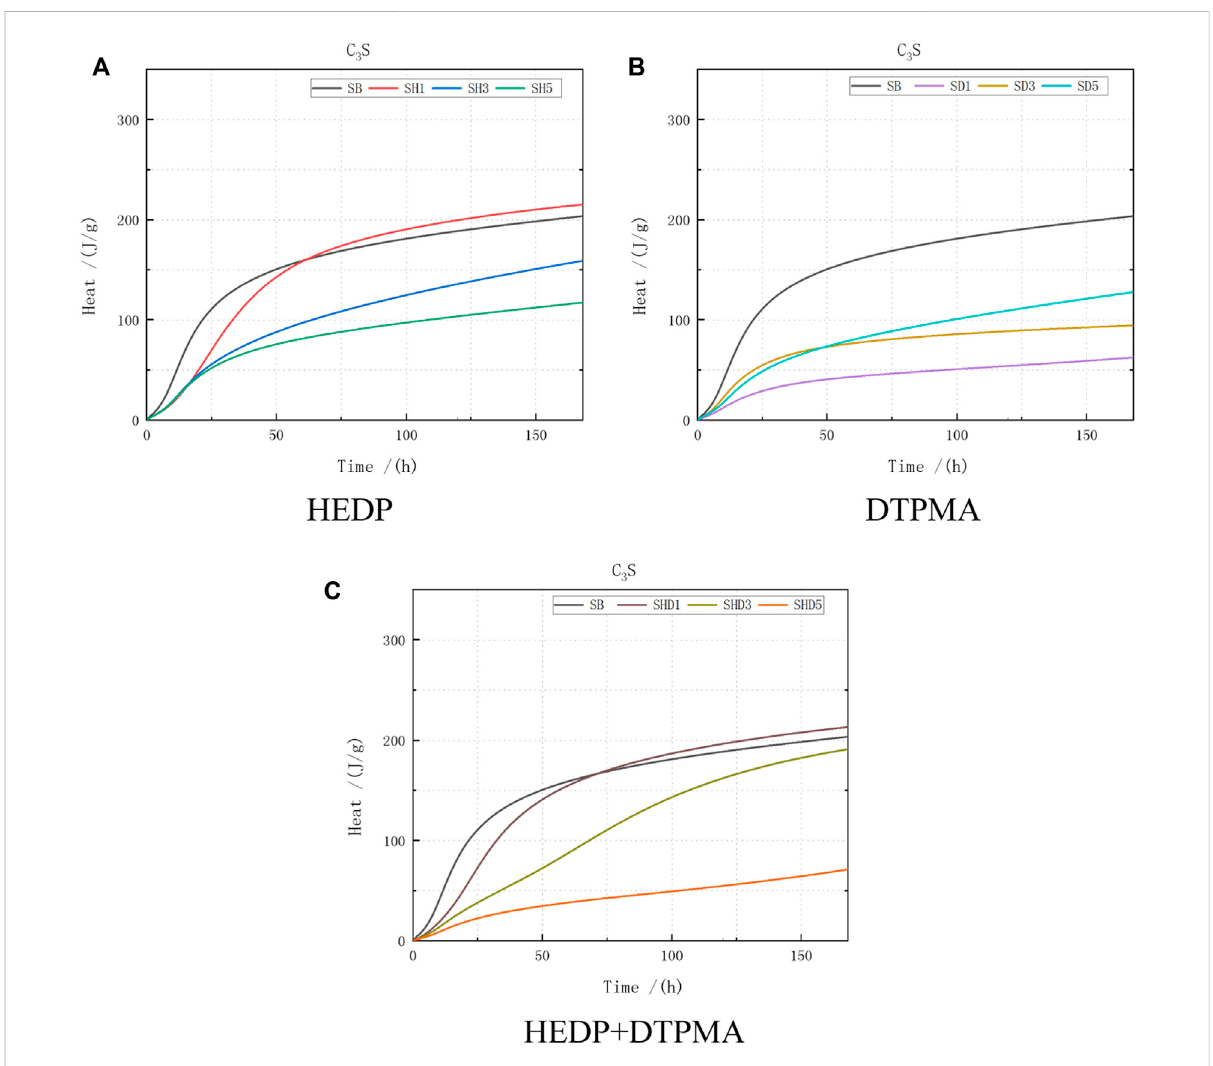
FIGURE 4 Heat of hydration data obtained from C 3 S combined with the following: (A) HEDP, (B) DTPMA, and (C) HEDP + DTPMA.